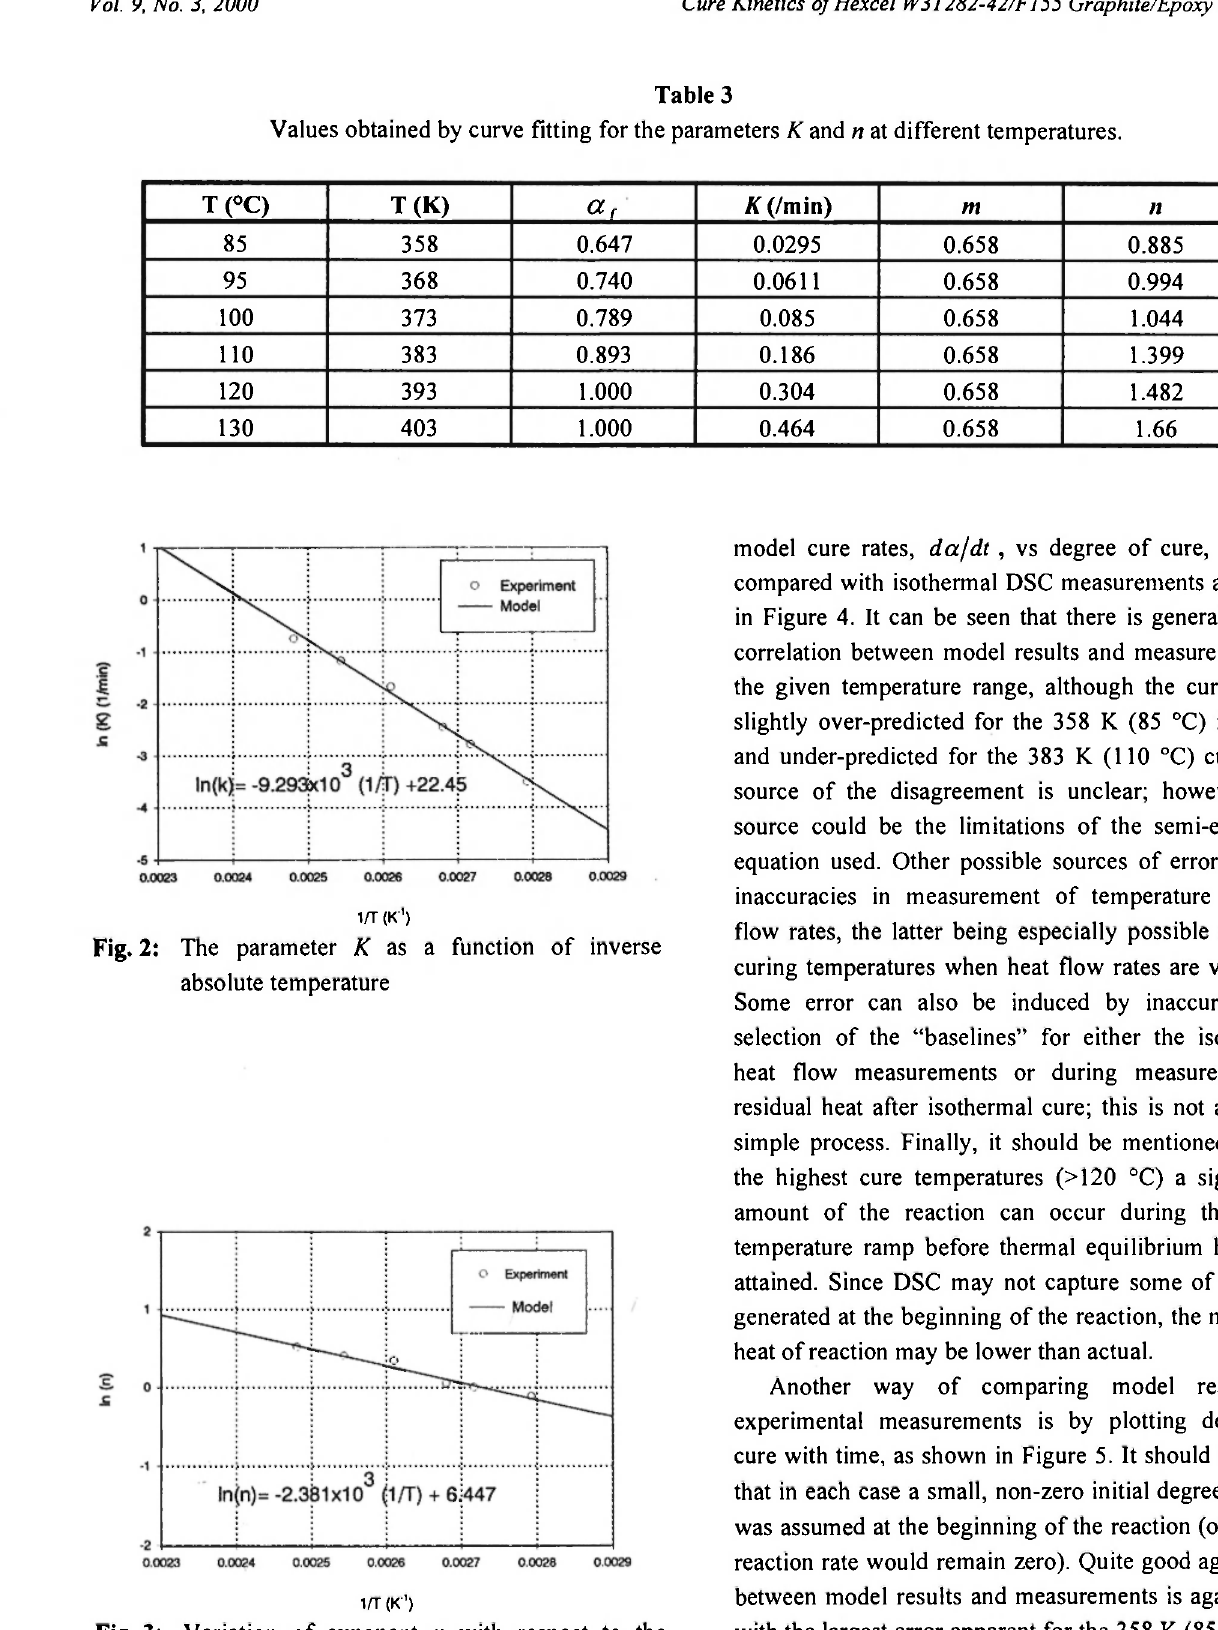
1/T (K" 1 ) Fig. 3: Variation of exponent η with respect to the inverse of absolute